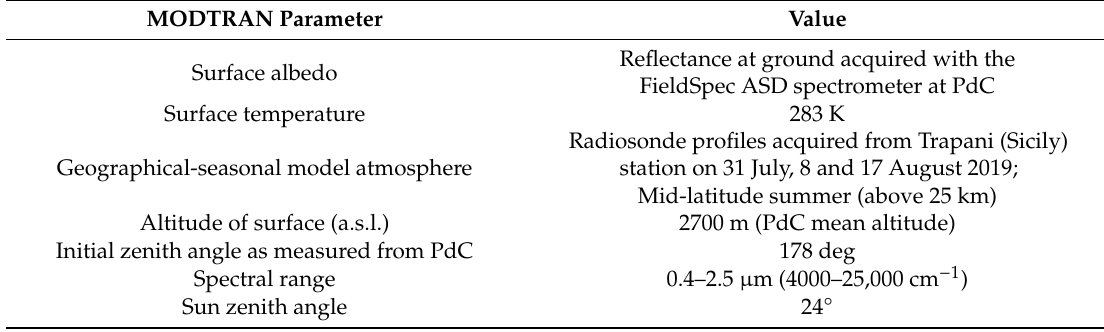
Table 2. Main input parameters for MODerate resolution atmospheric TRANsmission (MODTRAN) model runs.